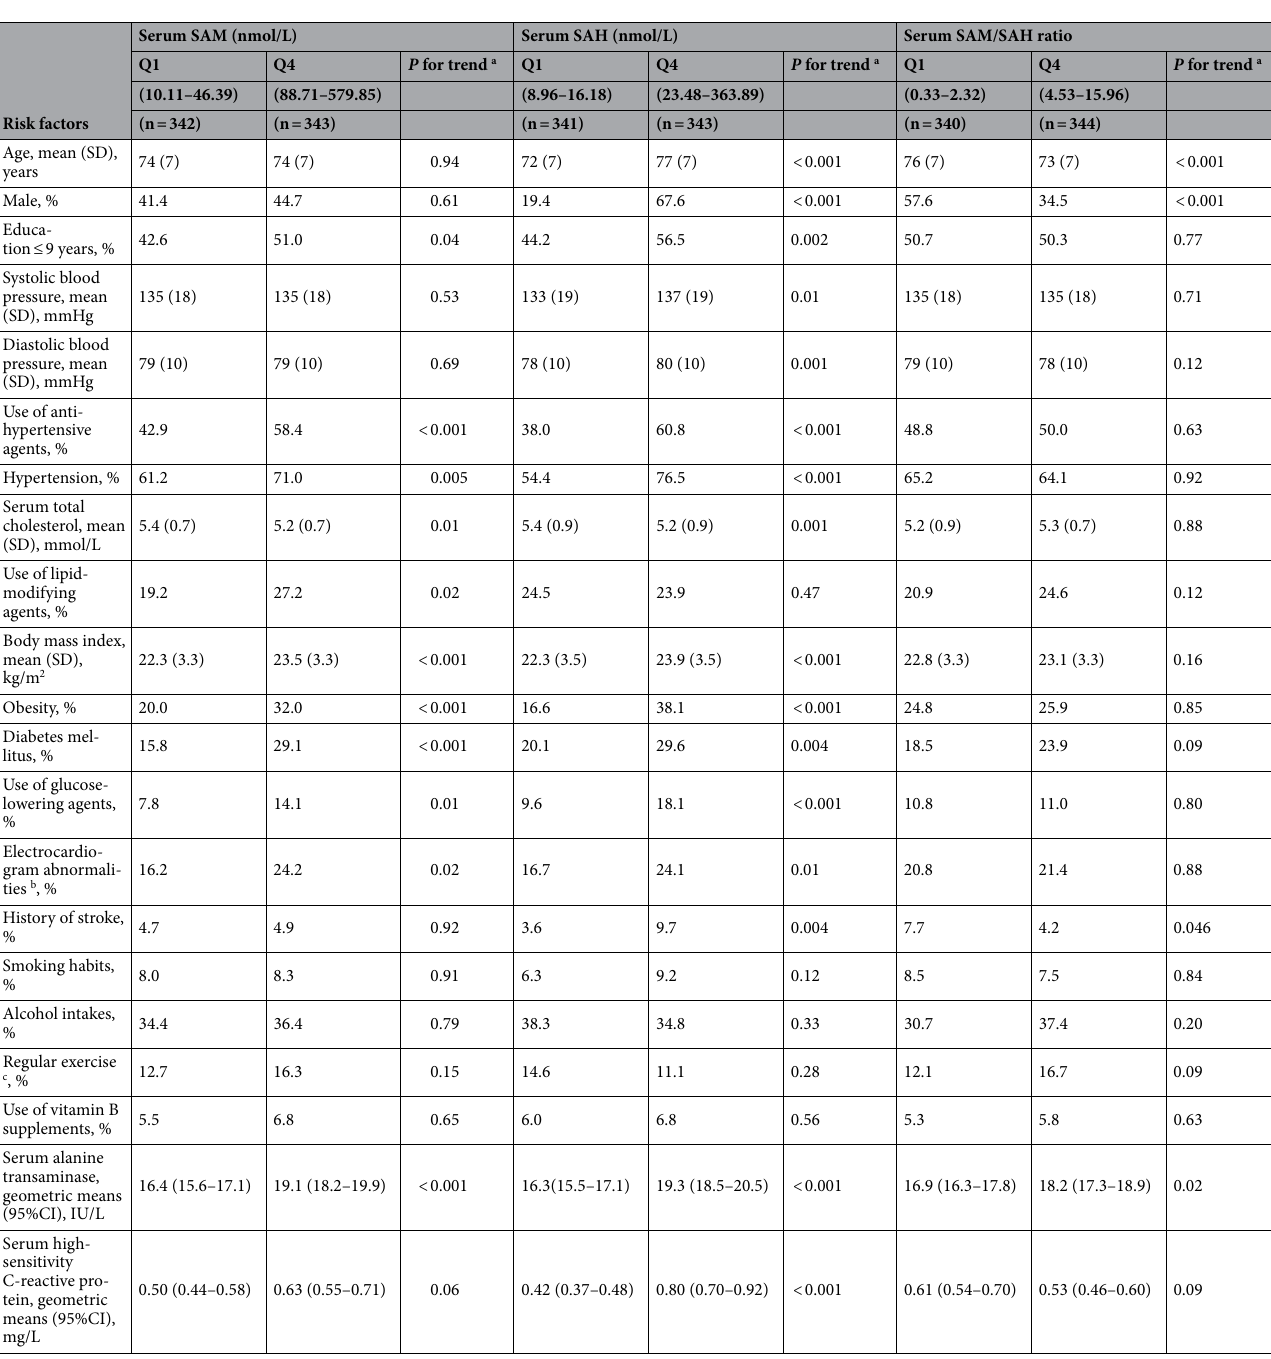
Table 1. Age- and sex-adjusted baseline characteristics of participants according to serum SAM, SAH and SAM/SAH ratio levels (2007). CI confidence interval, SAH s-adenosylhomocysteine, SAM s-adenosylmethionine, SD standard deviation. a This table shows the mean values or frequencies of risk factors only for the Q1 and Q4 groups among the quartiles of serum SAM, SAH and SAM/SAH ratio levels due to the size of the table. Trends of each value were tested across all quartile groups by using the linear or logistic regression model. The values for all quartile groups are shown in the Supplementary Table S1 for serum SAM levels, the Supplementary Table S2 for serum SAH levels and the Supplementary Table S3 for serum SAM/SAH ratio levels. b Electrocardiogram abnormalities were defined as left ventricular hypertrophy (Minnesota Code 3–1), ST depression (4–1, 2, 3), or atrial fibrillation (8–3). c Regular exercise was defined as engaging in sports or other forms of exercise at least three times a week during leisure